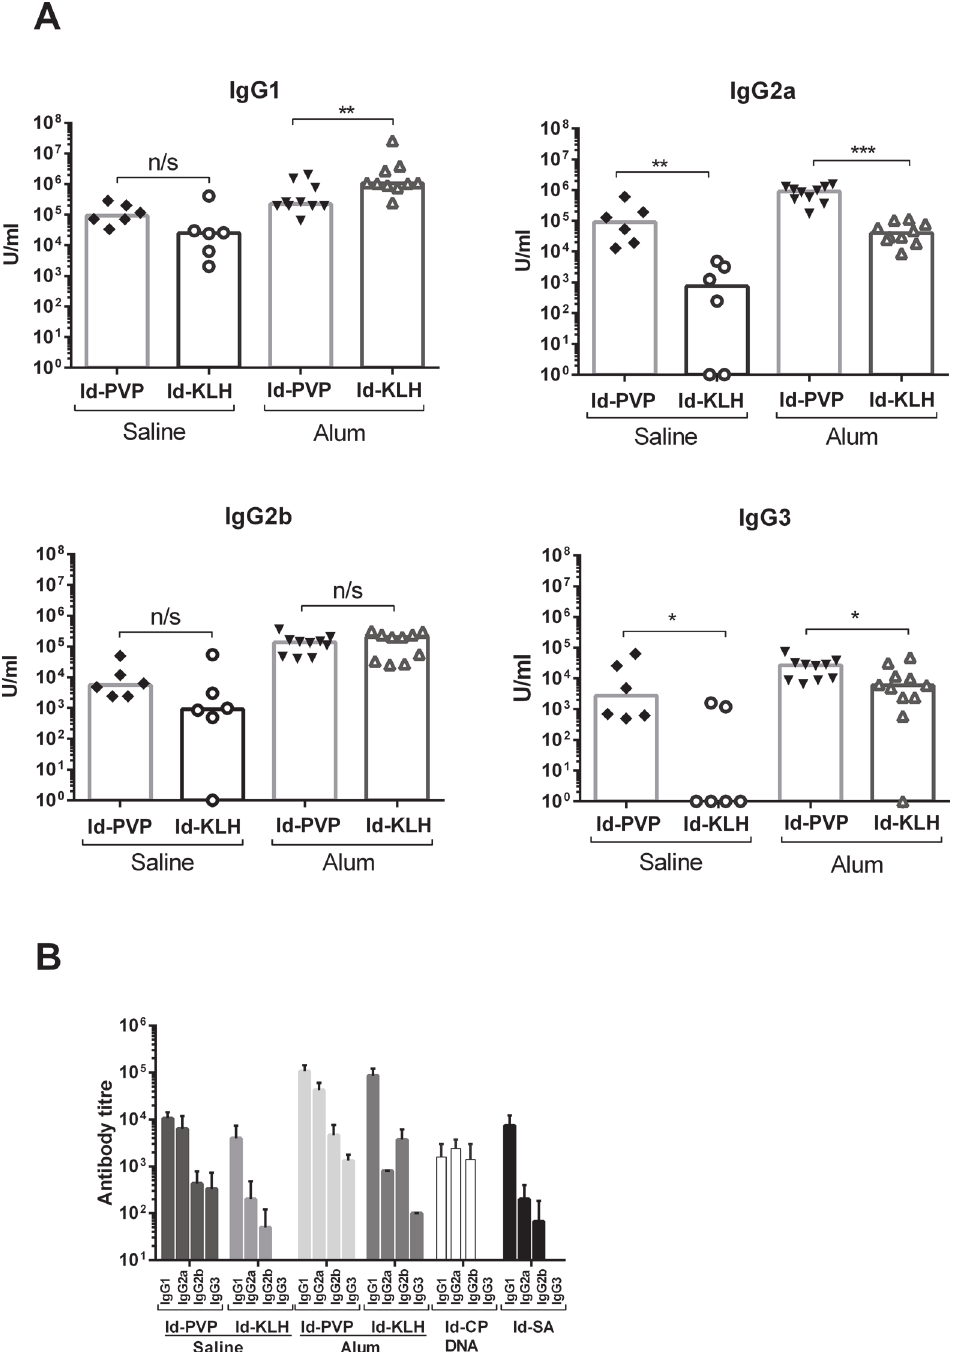
Fig 2. Antibody isotype analysis. (A) . The levels of anti-Id IgG antibody isotypes induced by Id-PVP and Id-KLH vaccines with or without alum were compared two weeks after booster vaccinations. U/ml represents the level of serum antibody compared to an internal standard. The data are combined from two independent experiments. Each symbol represents the response from an individual mouse, bars are medians. Mann-Whitney statistics were used for analysis, with one star indicating 0.01 < p < 0.05, two stars indicating 0.001 < p < 0.01 and three stars indicating p < 0.001. n/s is non-significant. 3 – 6 mice were included per group in each experiment. (B) . Anti-Id antibody isotype titres were measured two weeks after booster injection. The vaccines included Id-PVP and Id-KLH both with and without alum, the Id-CP DNA vaccine and Id-SA. Mean titres from three mice per group from one representative experiment are shown, with error bars showing standard